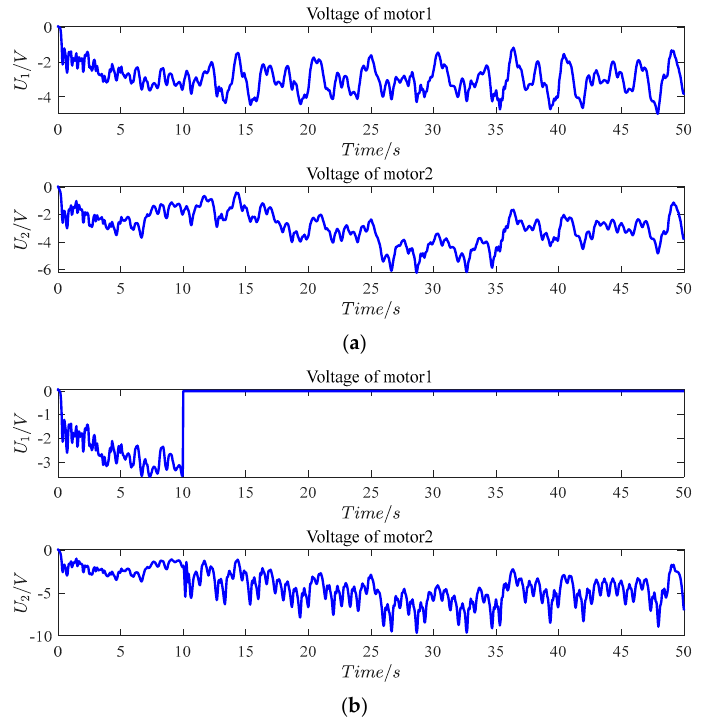
Figure 8. The control voltage of motors. ( a ) With actuator fault; ( b ) without actuator fault.